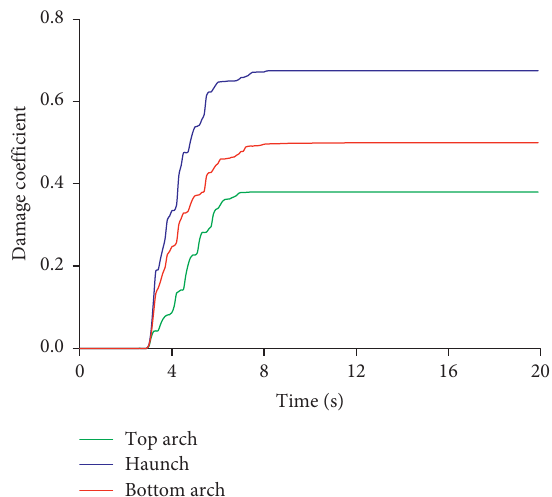
Figure 8: Damage coefficient time-history of monitoring points.